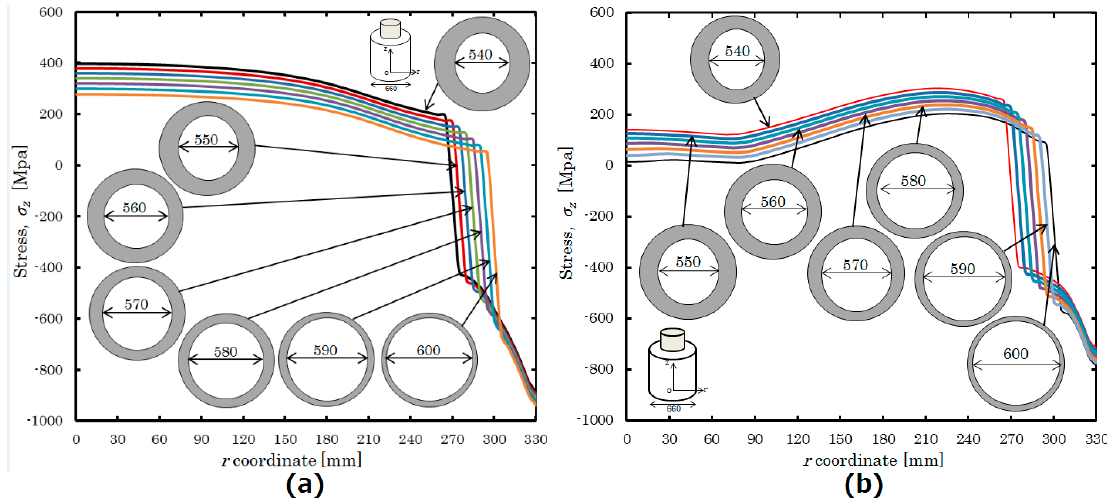
Figure 10. Residual stress distribution, σ z , for different area ratios. ( a ) Uniform heating; ( b ) non- uniform heating.